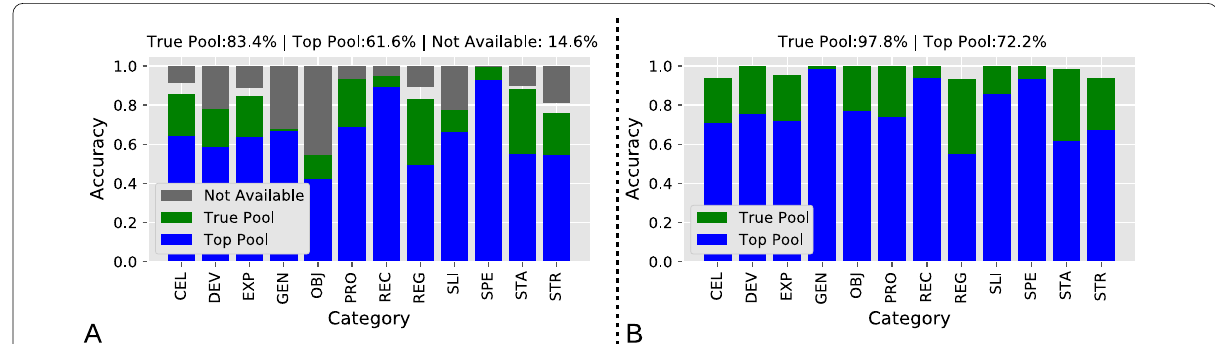
Fig. 4 Accuracy of metadata extraction from neuroscience articles by metadata category (see Table 1 for abbreviations). A. The Top Pool (blue bars) consists of the highest ranking recommended terms. The True Pool (green bars) includes all terms in the suggestion list regardless of rank. Gray bars from the top indicate the proportion of target metadata terms for which the article provides no information. The numerical value reported above the bar plot are averages of all metadata categories. B. Same data as in panel A with Not available (gray bars) removed and other values scaled